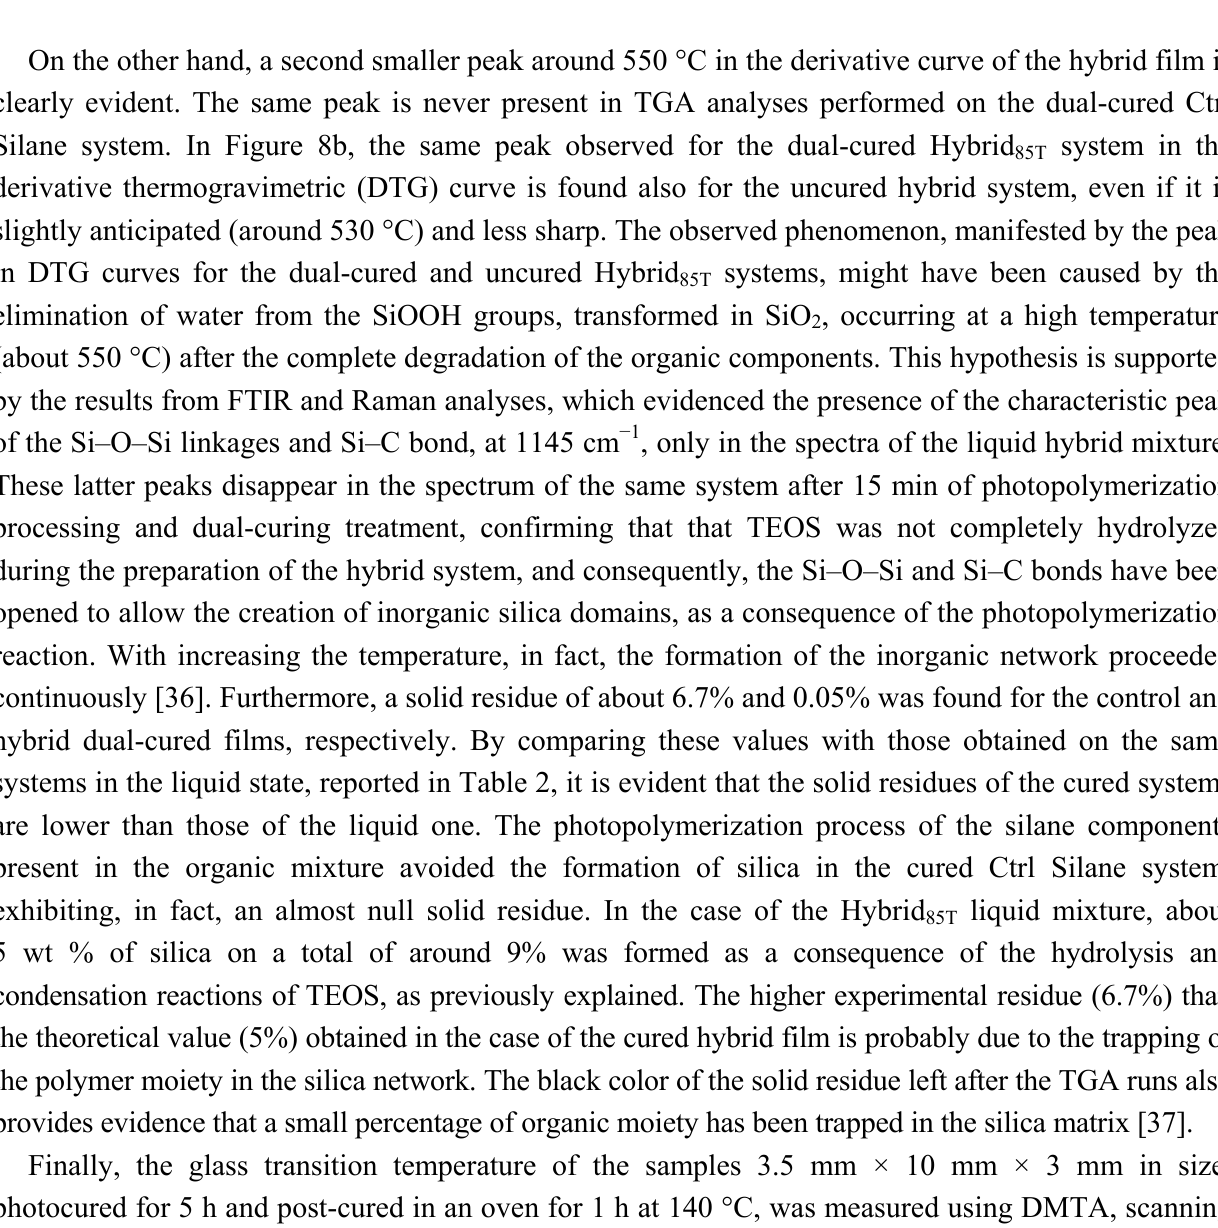
systems using 85T